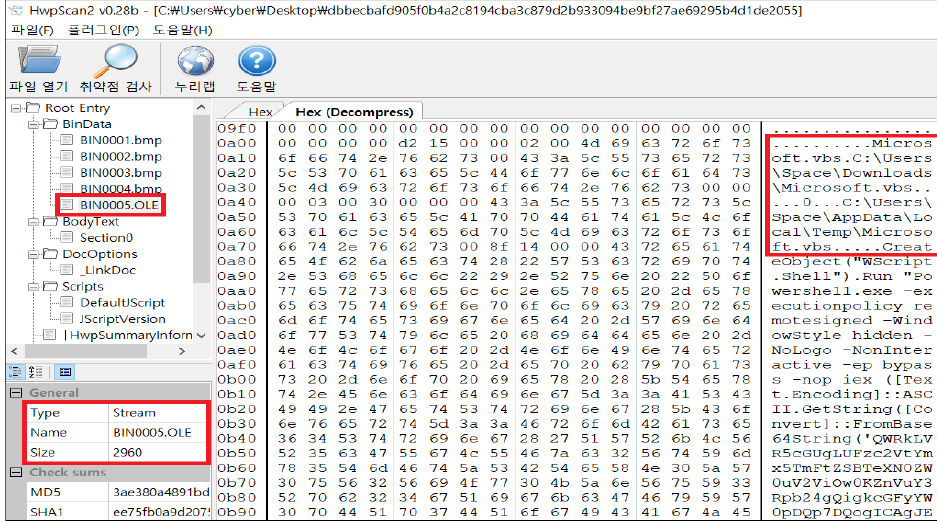
Figure 3. Malware screen included in the “BIN0005.OLE” area.